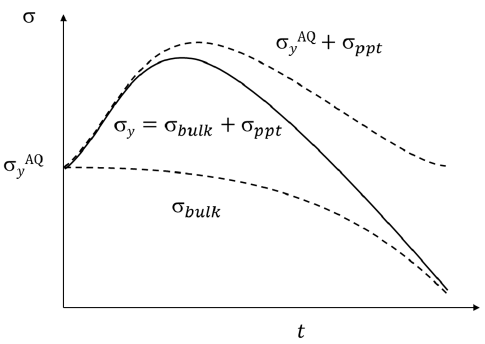
Figure 13. Schematic representation of the effects of precipitation and tempering on yield stress.